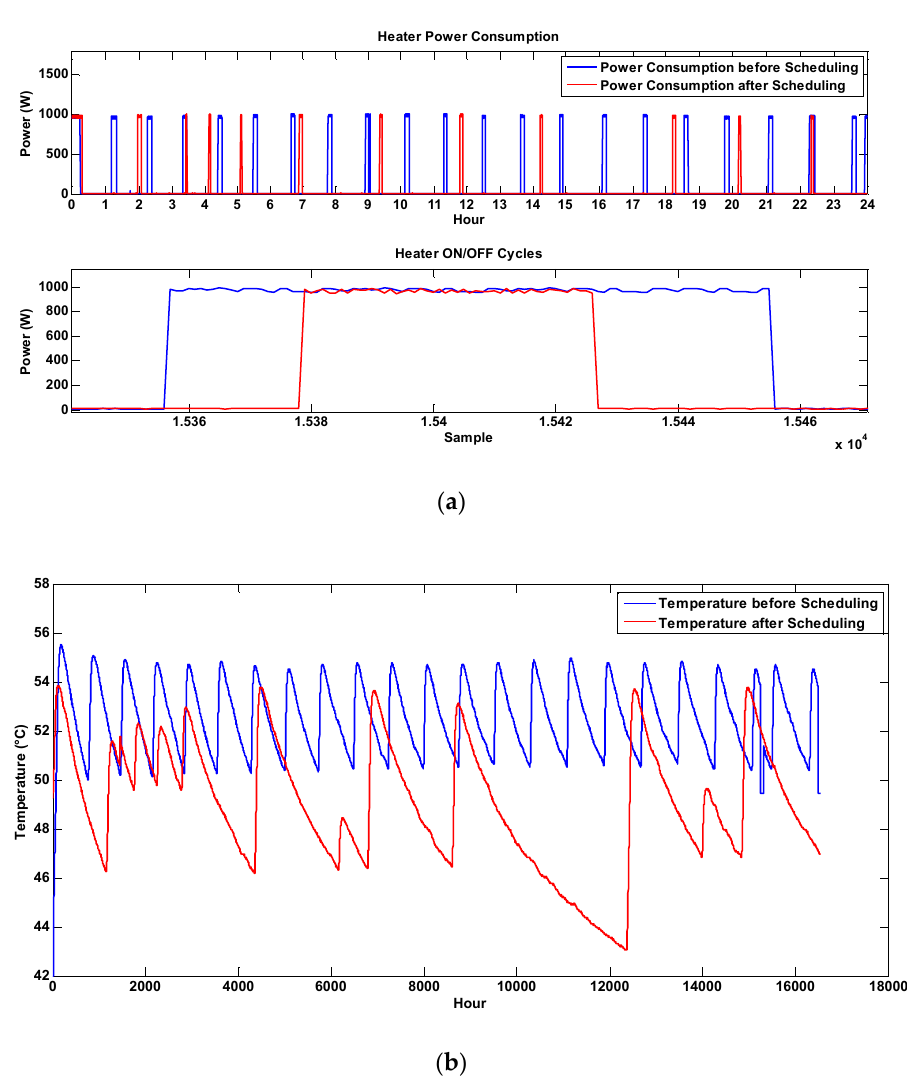
Figure 23. ( a ) Power consumptions and ( b ) heated water temperatures without and with the use of the HEM system.